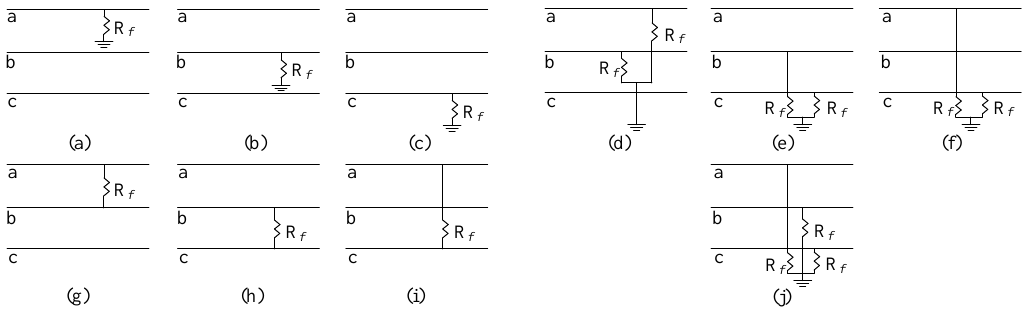
Figure 1. Representation of different fault types: ( a ) a-g, ( b ) b-g, ( c ) c-g, ( d ) ab-g, ( e ) bc-g, ( f )